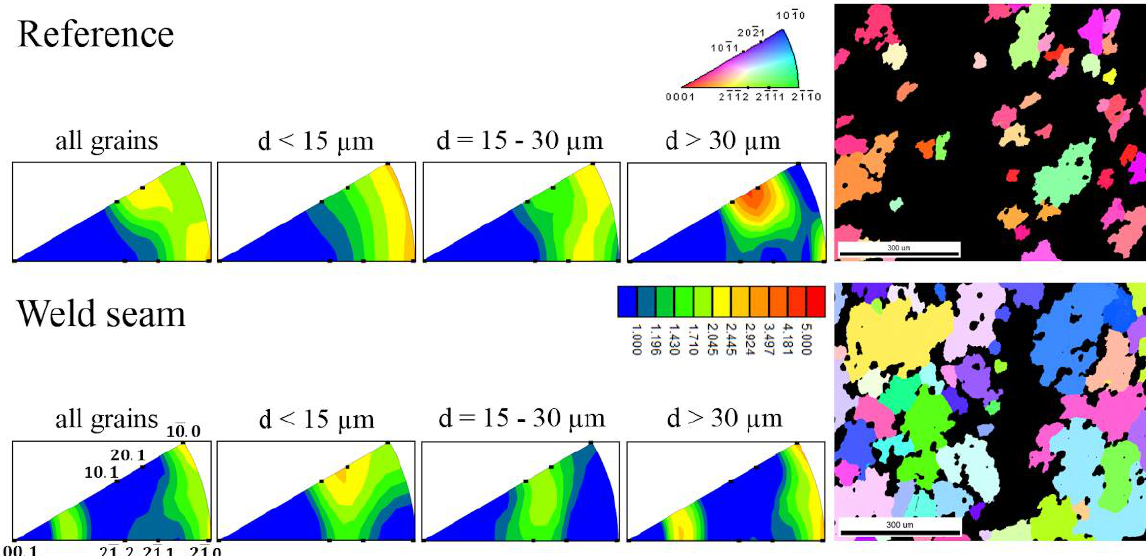
Figure 8. Comparison of the different IPFs of small grains originating from the initial microstructure (grain diameter < 15 µm), grains with a limited growth rate (grain diameter of 15–30 µm), and abnormally grown grains (grain diameter > 30 µm) after heat treatment at 475 °C for 3600 s. IPF maps ( ∥ ED) on the right-hand side provide size and distribution of abnormally grown grains (grain diameter > 30 µm), which were used to compute IPFs.